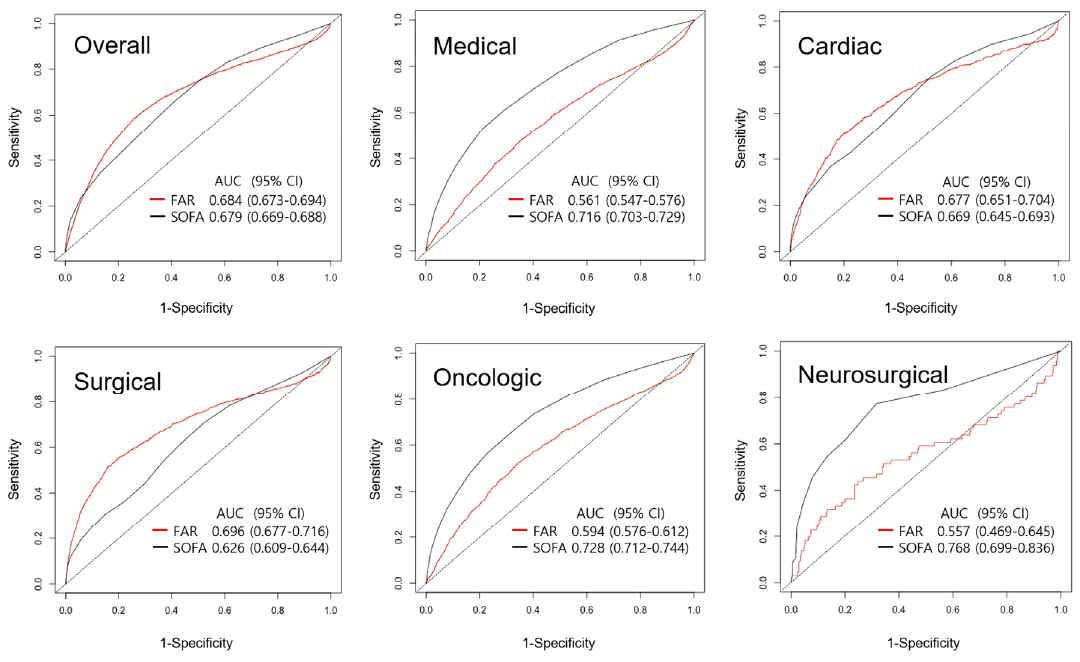
Figure 3. Receiver operating characteristic curves for prediction of 1-year mortality using fibrino- gen/albumin ratio (FAR) and Sequential Organ Failure Assessment (SOFA) score. AUC, areas under the curve; CI, confidence interval.